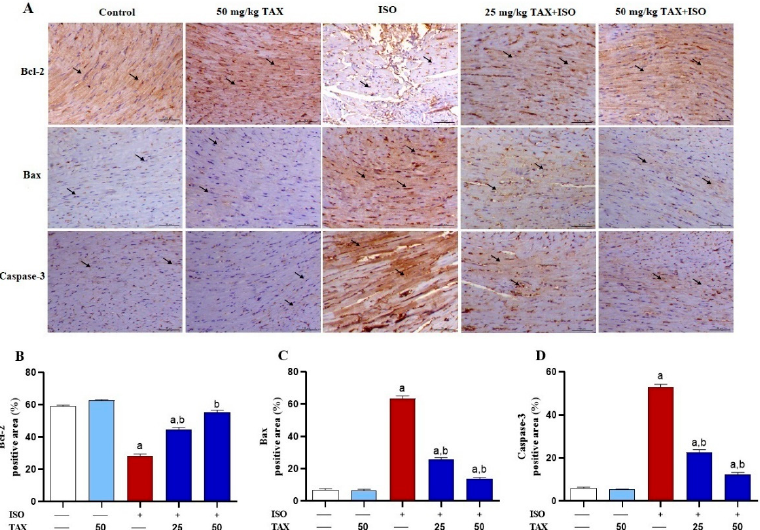
Figure 7. TAX attenuates the ISO-induced myocardial apoptosis in mice. ( A ) Images of the microscopic field of IHC labeled cardiac sections from control and TAX-treated mice, showing obvious expression of Bcl-2 within the myocardial fibers (arrows), along with mild expression of myocardial Bax and caspase-3 (arrows); ISO-injected mice demonstrating a noticeable reduction in the myocardial level of Bcl-2 (arrows), along with remarkably increased myocardial Bax and caspase-3 (arrows); and mice treated with 25 and 50 mg/kg TAX before ISO injection demonstrating a noticeable increase in myocardial expression of Bcl-2 (arrows), along with a marked reduction in the expression of Bax and caspase-3 in the myocardial tissues (arrows). (IHC, X200, Scale bar = 50 µ m). ( B – D ) Analysis of the relative intensities of the images of IHC-labeled myocardial Bcl-2, Bax, and caspase-3, showing a significantly increased Bcl-2 and decreased Bax and caspase-3 in mice pre-treated with both doses of TAX. Data are expressed as mean ± SEM, ( n = 6). Here, a indicates significant ( p < 0.05) vs. control, while b indicates significant ( p < 0.05) vs.